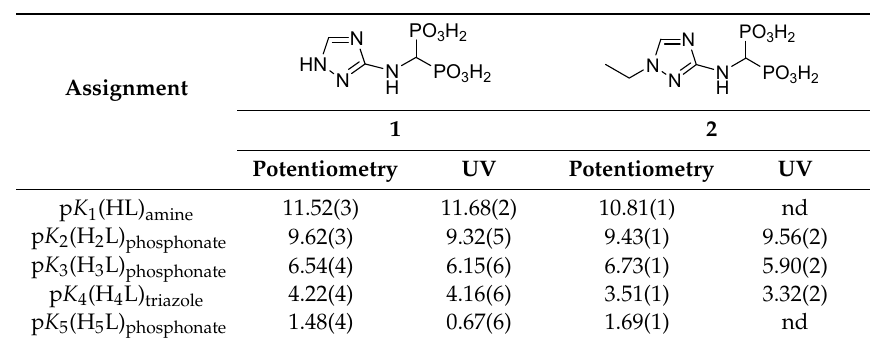
Table 2. The protonation constants of 1 and 2 measured in 0.1 M KCl at 25 °C. Concentrations of the